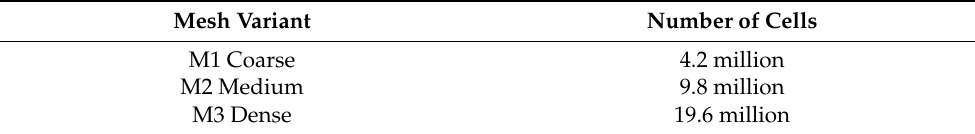
Table 3. Number of cells used in numerical grids used in the grid sensitivity analysis.